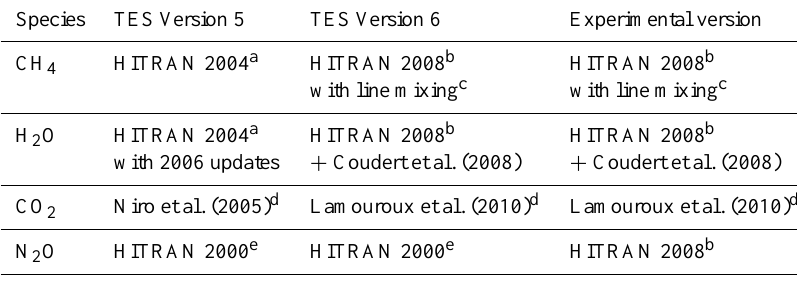
Table 1. Sources of spectroscopic line parameters used in this